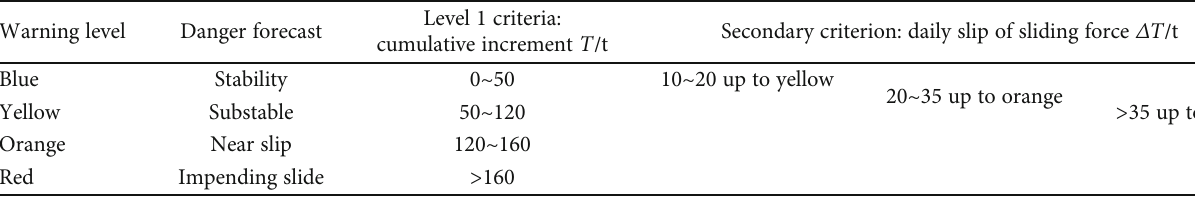
Table 4: Warning level and warning criteria.